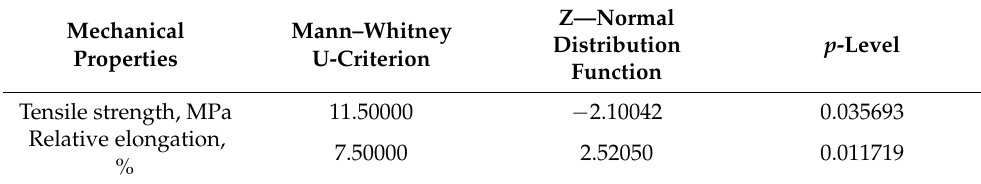
Table 3. Nonparametric analysis of the effect of sample thickness on mechanical